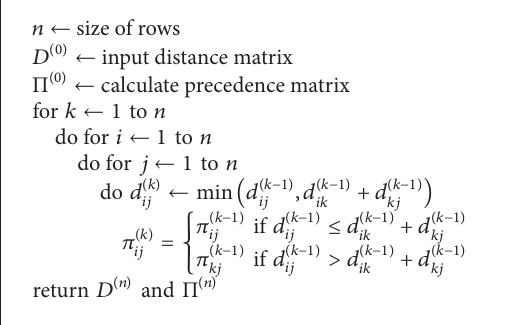
Algorithm 1: Floyd-Warshall algorithm for the all-pairs-shortest- path